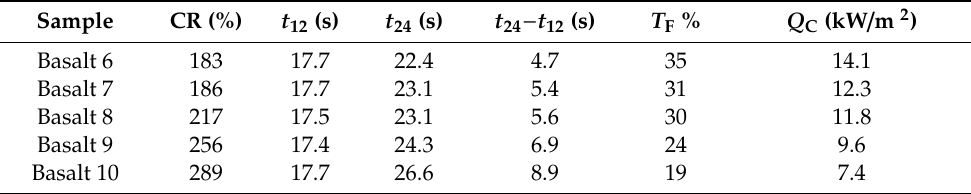
Table 3. Heat transfer parameters of plasma-treated basalt fabrics coated with di ff erent silicone contents (CR